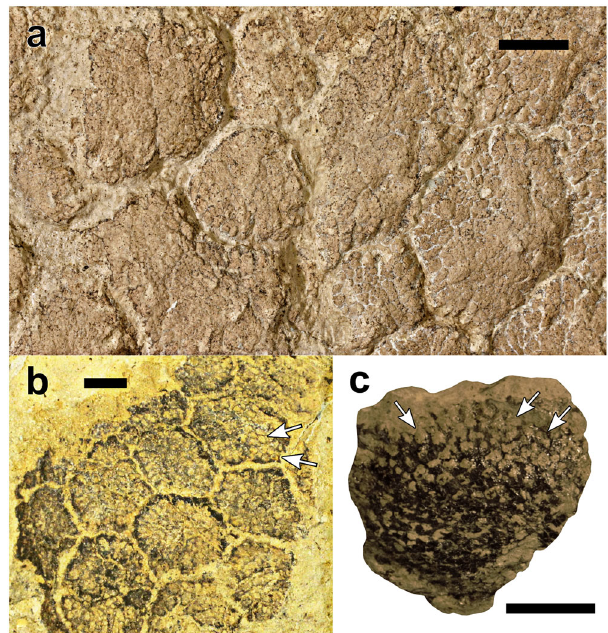
Fig. 4 Exemplary sauropod skin specimens showing similar intrascale papilliform surface textures to those of NHMUK R1868. a Skin from the scapular region of the non-titanosauriform macronarian Tehuelchesaurus benitezii (MPEF-PV 1125/1), from the Cañadón Calcáreo Formation (Upper Jurassic) of Argentina (photo: E. Ruigomez). b Section of integument (CMC VP8075) from the diplodocid Diplodocus sp., from the Mother ’ s Day Quarry within the Morrison Formation (Upper Jurassic) of Montana, USA (photo: M. Rubin). c Single scale of an indeterminate sauropod, most likely Apatosaurus sp. (part of MWC 5537), from the Mygatt-Moore Quarry within the Morrison Formation (Upper Jurassic) of Colorado, USA (photo: J. McHugh). Arrows in b and c indicate exemplary papillae that are worn and exposed in cross section. All scale bars equal 1 distribution of intrascale papillae, their consistent sur fi cial visibility, and the higher preservation potential of corni fi ed epidermis (compared to the softer dermis e.g. 15 ) does not preclude an epidermal origin. Histological analysis will be required to con fi rm their precise structural af fi nities. However, due to the historic nature of NHMUK R1868 as the fi rst-known holotype of Haestasaurus becklesii 2 , destructive sampling of this block was not permitted and could not be performed. Future